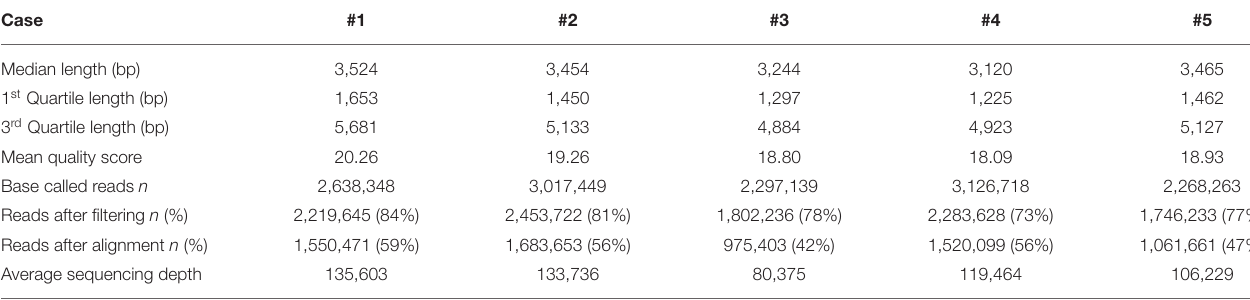
TABLE 1 | Read statistics derived from MinION sequencing data for each